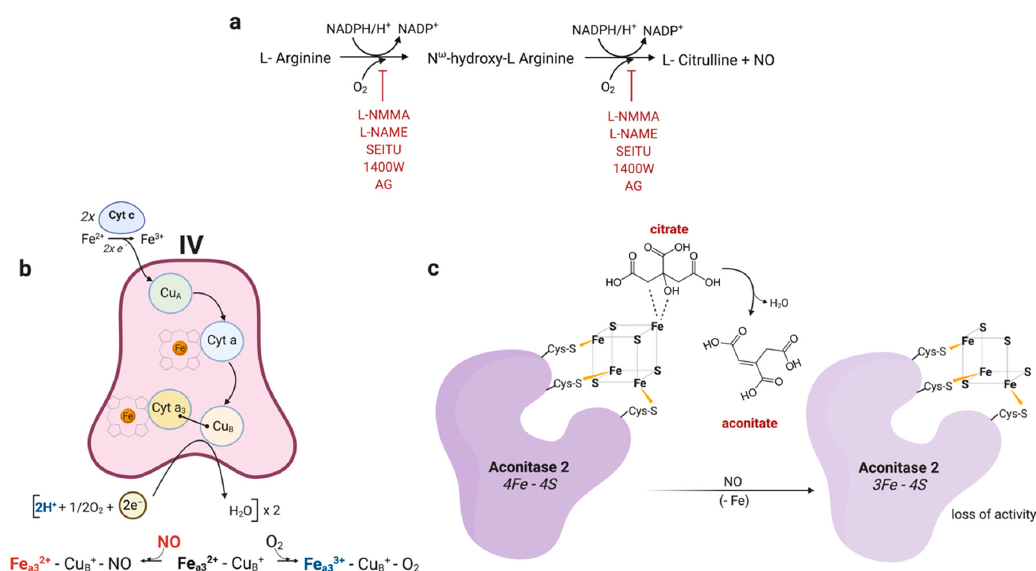
Figure 1. Biochemical mechanisms of Nitric Oxide synthesis and inhibition of mitochondrial targets. ( a ) Nitric oxide (NO) is synthesized from L -arginine by nitric oxide synthase (NOS) enzymes. The reaction involves the incorporation of oxygen (O 2 ) into the unstable intermediate L -arginine and, subsequently, into L -citrulline, co-product of the generation of NO. N G -monomethyl- L -arginine (L-NMMA), N omega-Nitro- L -arginine (L-NAME), S -ethylisothiourea (SEITU), N -(3-(Aminomethyl)benzyl)acetamidine (1400W), and aminoguanidine (AG) are competitive inhibitor of points indicated. ( b ) Nanomolar concentrations of NO immediately, specifically, and reversibly inhibit cytochrome c oxidase (Complex IV of mitochondrial electron transport chain, ETC) in competition with oxygen. NO reacts with the metals of the binuclear site of cytochrome c oxidase, binding tightly